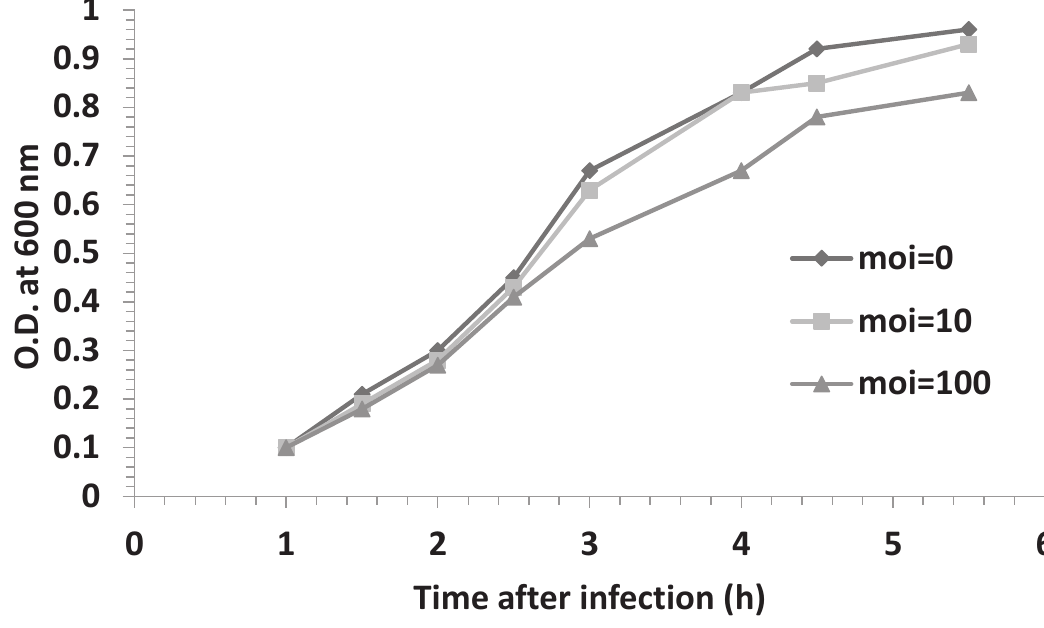
Figure 4. Effect of moi on the growth profile of infected HBT(pOri1). HBT(pOri1) cultures were infected at moi = 10 or 100 and the bacterial growth monitored at the indicated. The growth of an uninfected culture (moi = 0) was monitored as control.